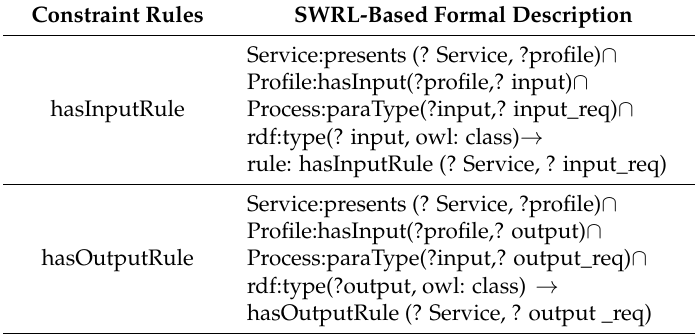
Table 2. Examples of semantic matching rules and their formal description. SWRL: Semantic Web Rule Language.